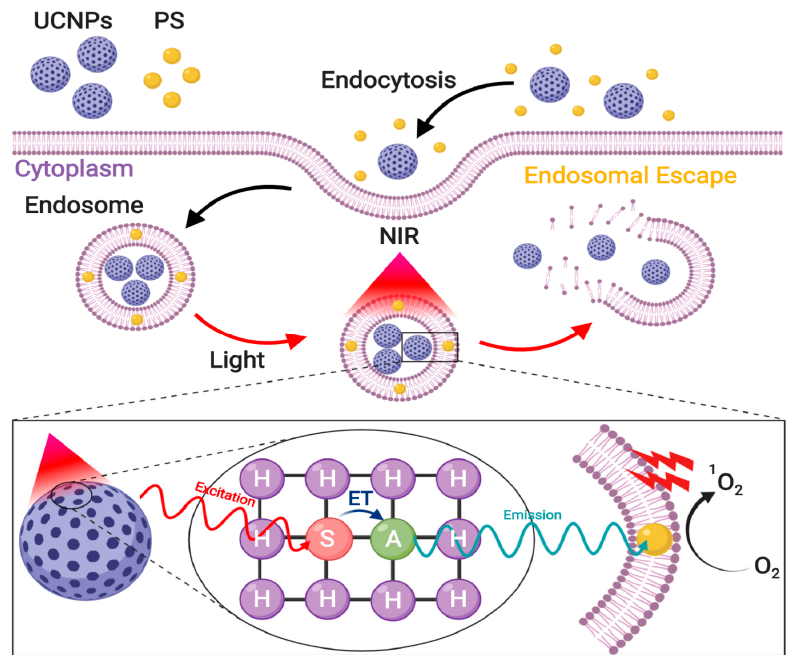
Figure 9. Schematic illustration of the PCI process by using upconverted nanoparticles (UCNPs). UCNPs and photosensitizers (PS) are endocytosed by the cell and colocalized with endosomal vesicles. PS intercalate within endosomal membranes due to their amphiphilic properties. After NIR irradiation, sensitizer ions (S) absorb the energy and transfer it to activator ions (A) capable of emitting radiation (UV or Vis). PS then absorb the energy and transfer it to molecular oxygen, thereby generating highly toxic singlet oxygen. These molecules cause important oxidative damage in the endocytic membranes, which ultimately leads to endosomal escape by their disruption. ET: energy transfer, H: host matrix (Created with BioRender.com)